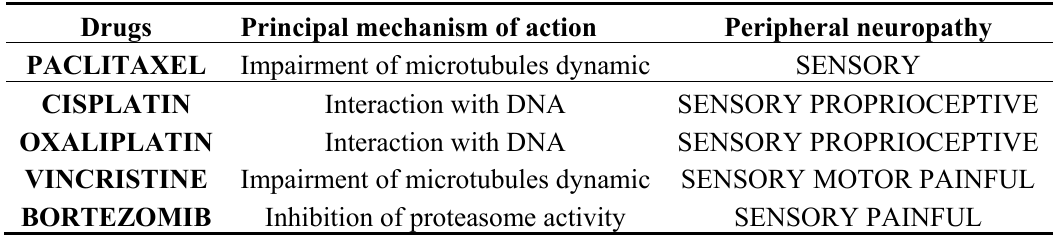
Table 1. Paclitaxel, cisplatin, oxaliplatin, vincristine and bortezomib: chemical structures, principal mechanism of action and peripheral